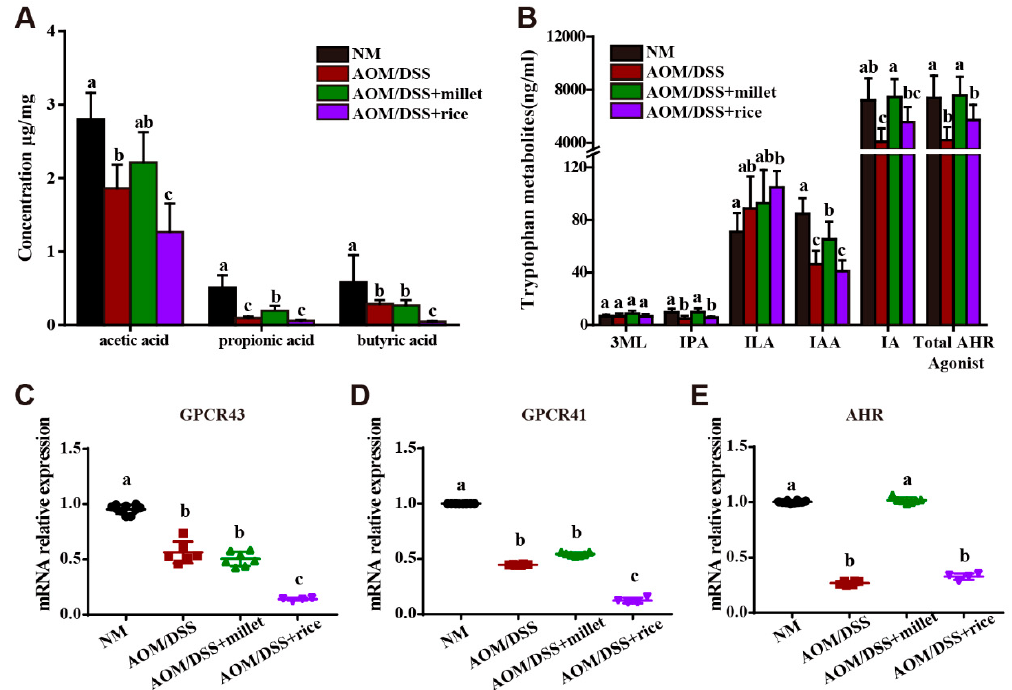
Figure 6. The concentrations of SCFAs ( A ) and tryptophan metabolites in feces ( B ). The mRNA expression levels of GPCR43 ( C ), GPCR41 ( D ), and AHR ( E ) in the colon. Data are shown as the mean ± SD. Means with different letters are significantly different ( p < 0.05). n = 10, 6, 7, and 4 for NM, AOM/DSS, AOM/DSS + millet, and AOM/DSS + rice groups, respectively.